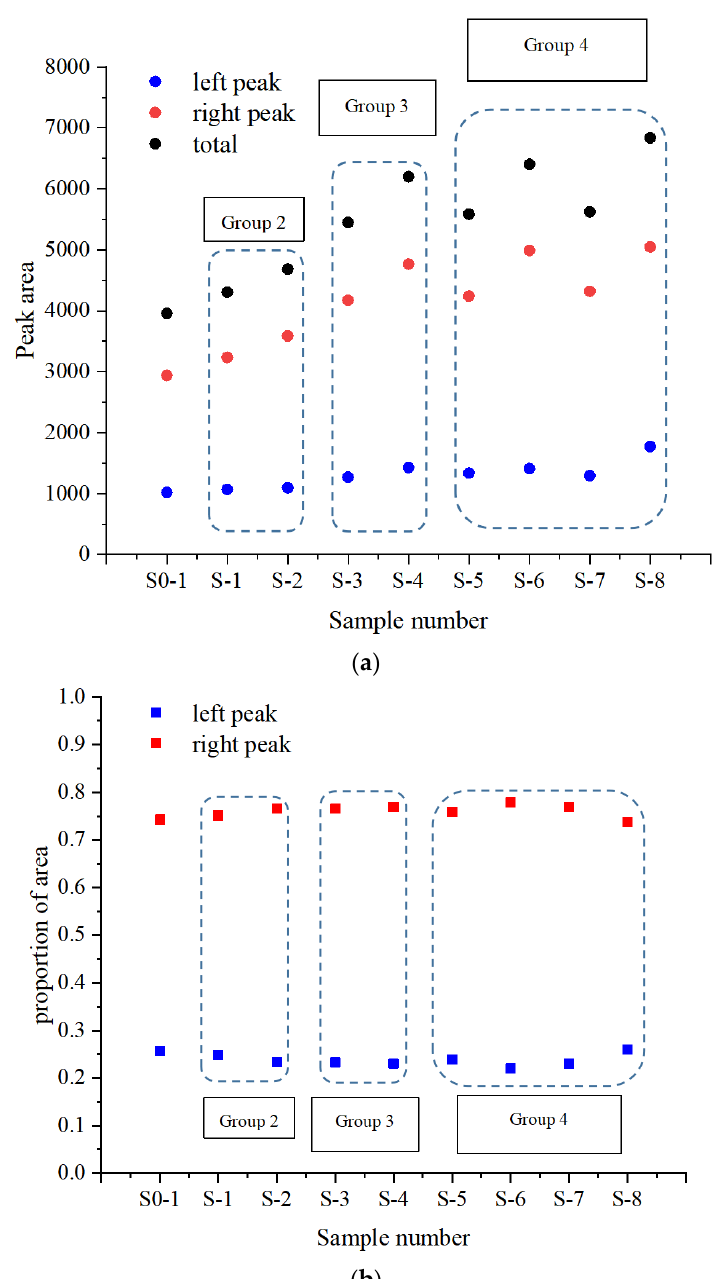
Figure 5. Left and right peak area in T 2 spectra of granite under different stimulation experiments: ( a ) Peak area of each sample; ( b ) Proportion of peak area.